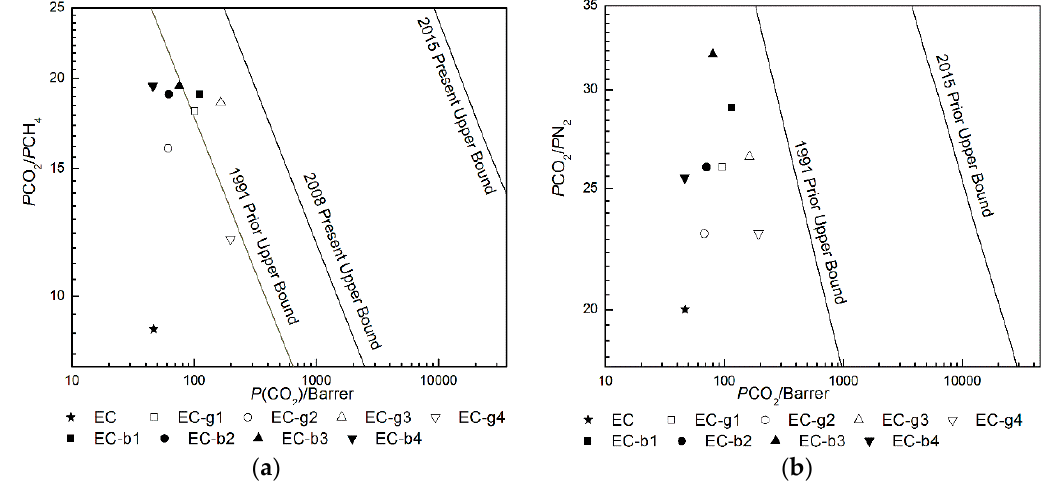
/ CH / N 2 4 and ( b ) CO 2 2